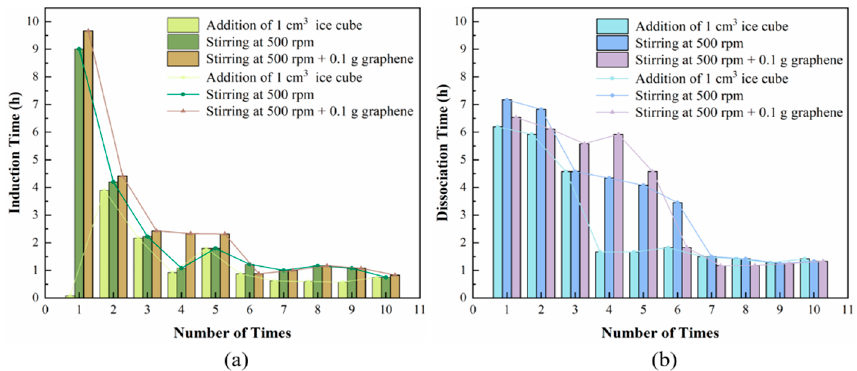
Figure 5. Changes in the formation and dissociation times of TBAB/TBAC in the cyclic hydrate formation experiment, indicating stability with different promotion measures (addition of 1 cm 3 ice cube, stirring at 500 rpm, and stirring at 500 rpm + 0.1 g graphene). ( a ) Relationship between induction time and formation cycles; ( b ) relationship between dissociation time and dissociation cycles.